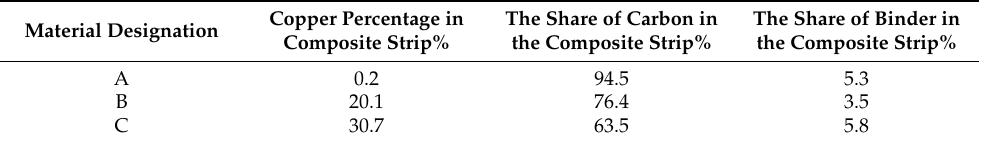
Table 1. Copper percentage in the carbon–copper composite strips [21].